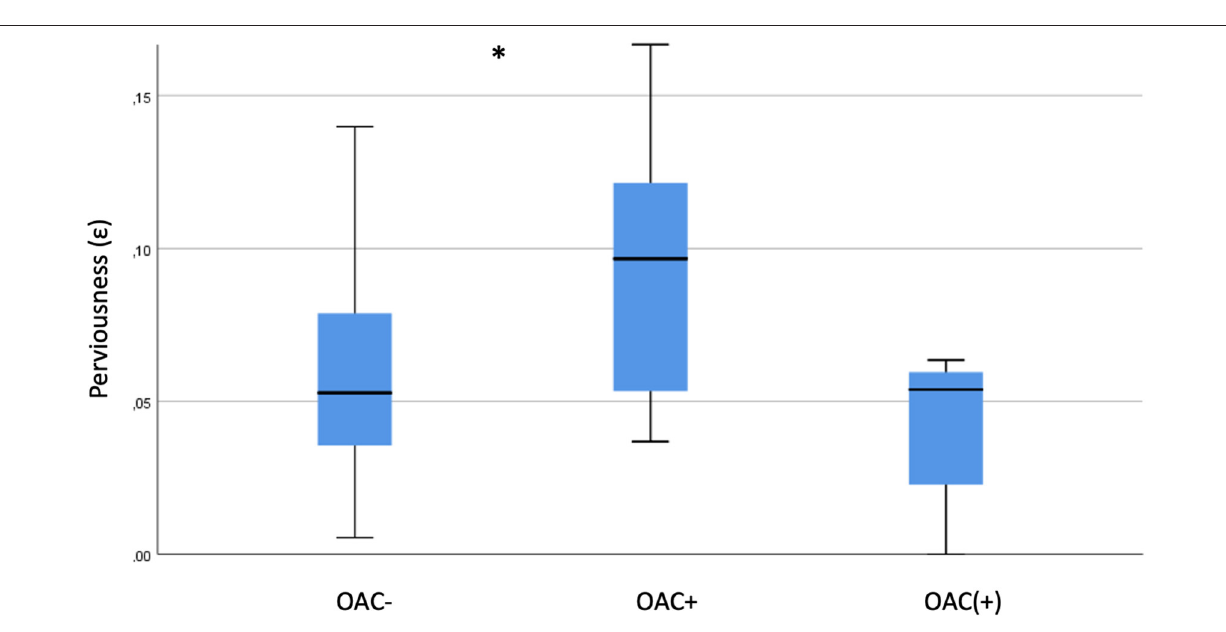
(0.09 ± 0.06) than in thrombi without anticoagulation ( n = 38; 0.06 ± 0.03; p = 0.04; as shown in Figure 3B ). The other imaging characteristics (change in thrombus attenuation 1 t and native clot density) were higher for OAC + thrombi ( 1 t: 17.2 ± 7 HU/clot density: 59.8 ± 45 HU) than for OAC– thrombi ( 1 t: 14.5 ± 10 HU; p = 0.2/clot density: 43.2 ± 10 HU; p = 0.4), but without statistic level of